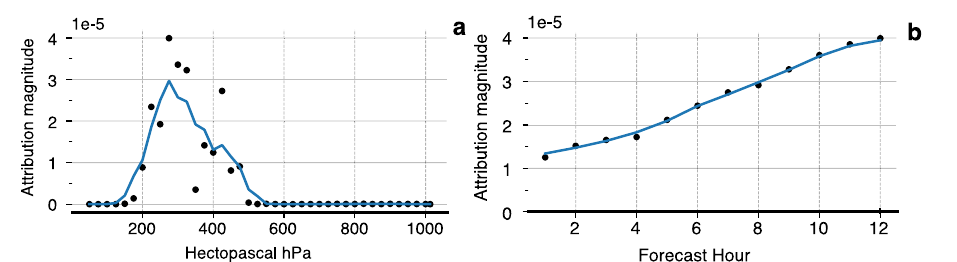
Fig. 8 | Attribution analysis for MetNet-2. Attribution of Absolute Vorticity, i.e., the amount a single input pixel contributesto a singlepixel probability prediction. a Attribution of absolute vorticity at pressure levels 50hPa to 1013hPa on the 12h